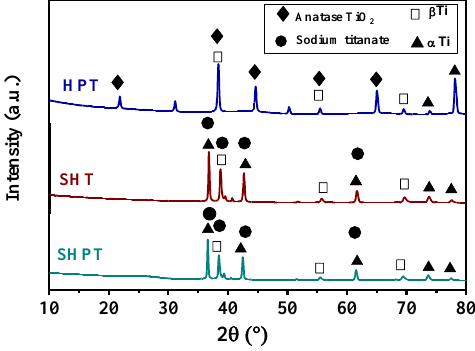
Figure 3. XRD patterns of treated specimens.